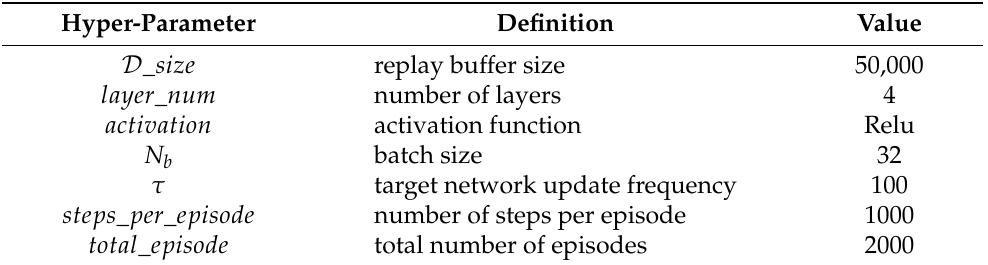
Table 1. The Hyper-parameter Settings of the